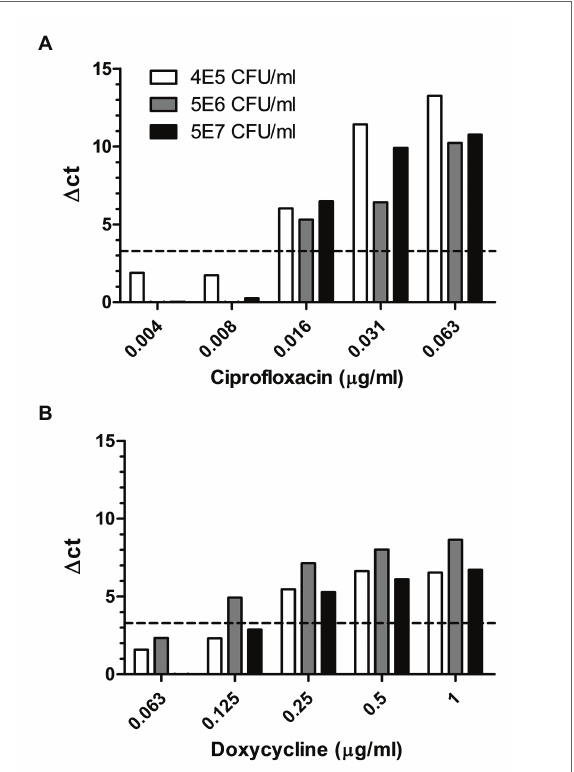
FIGURE 4 | Environmental samples spiked with different concentrations of F. tularensis . Different environmental samples spiked with 5E7, 5E6, and 6E5 cfu/ml of F. tularensis were subjected to MAPt. MIC was determined, as described in materials and methods, by the thresholds of ∆ CT = 3.3. (A) Ciprofloxacin and (B)